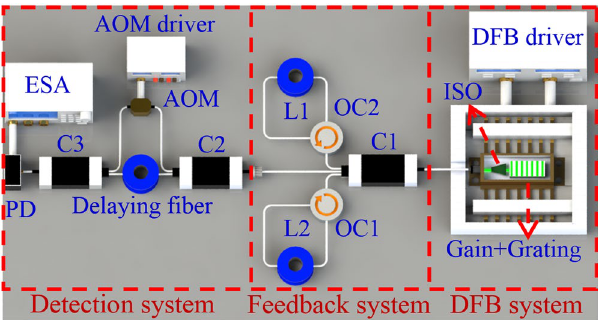
Figure 4. Schematic of DFB dual-cavity self-feedback structure.